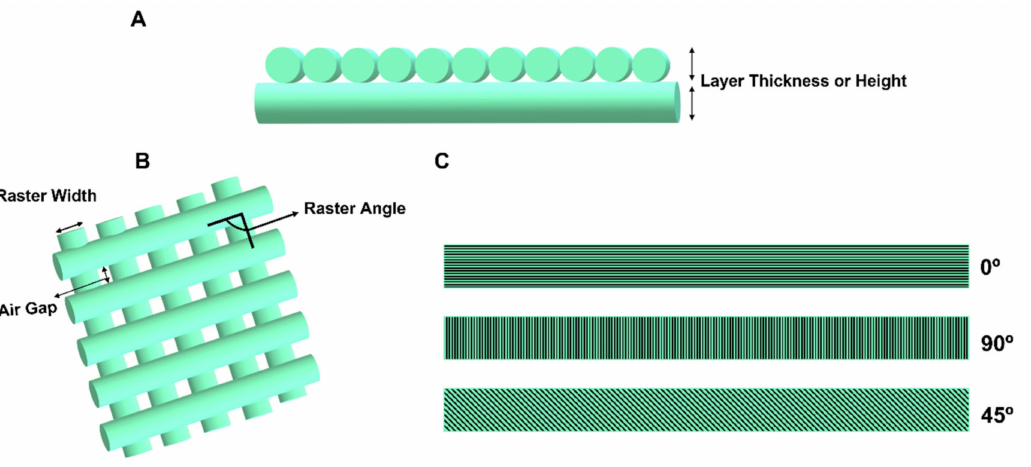
Figure 11. Schematic representation of some FFF printing parameters: ( A ) layer thickness; ( B ) air gap, raster orientation, and raster width; ( C ) examples of raster